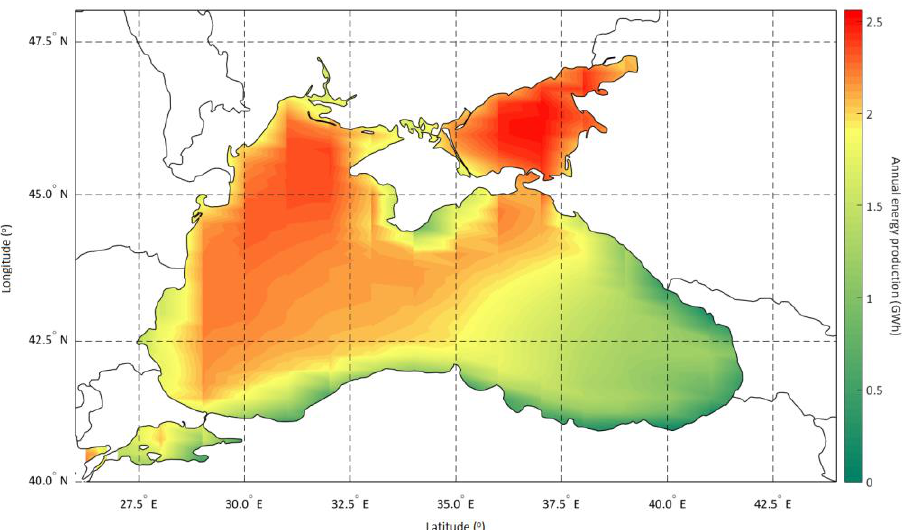
Figure 8. Airborne 500 kW — annual energy production (in GWh) computed for the total time interval by using the U200 wind conditions.